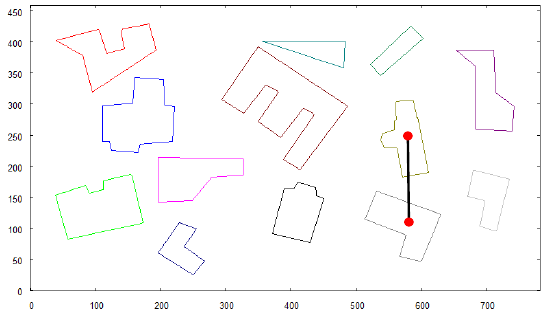
Figure 10. Vectorized map of terrain with objects that were recognized being marked.